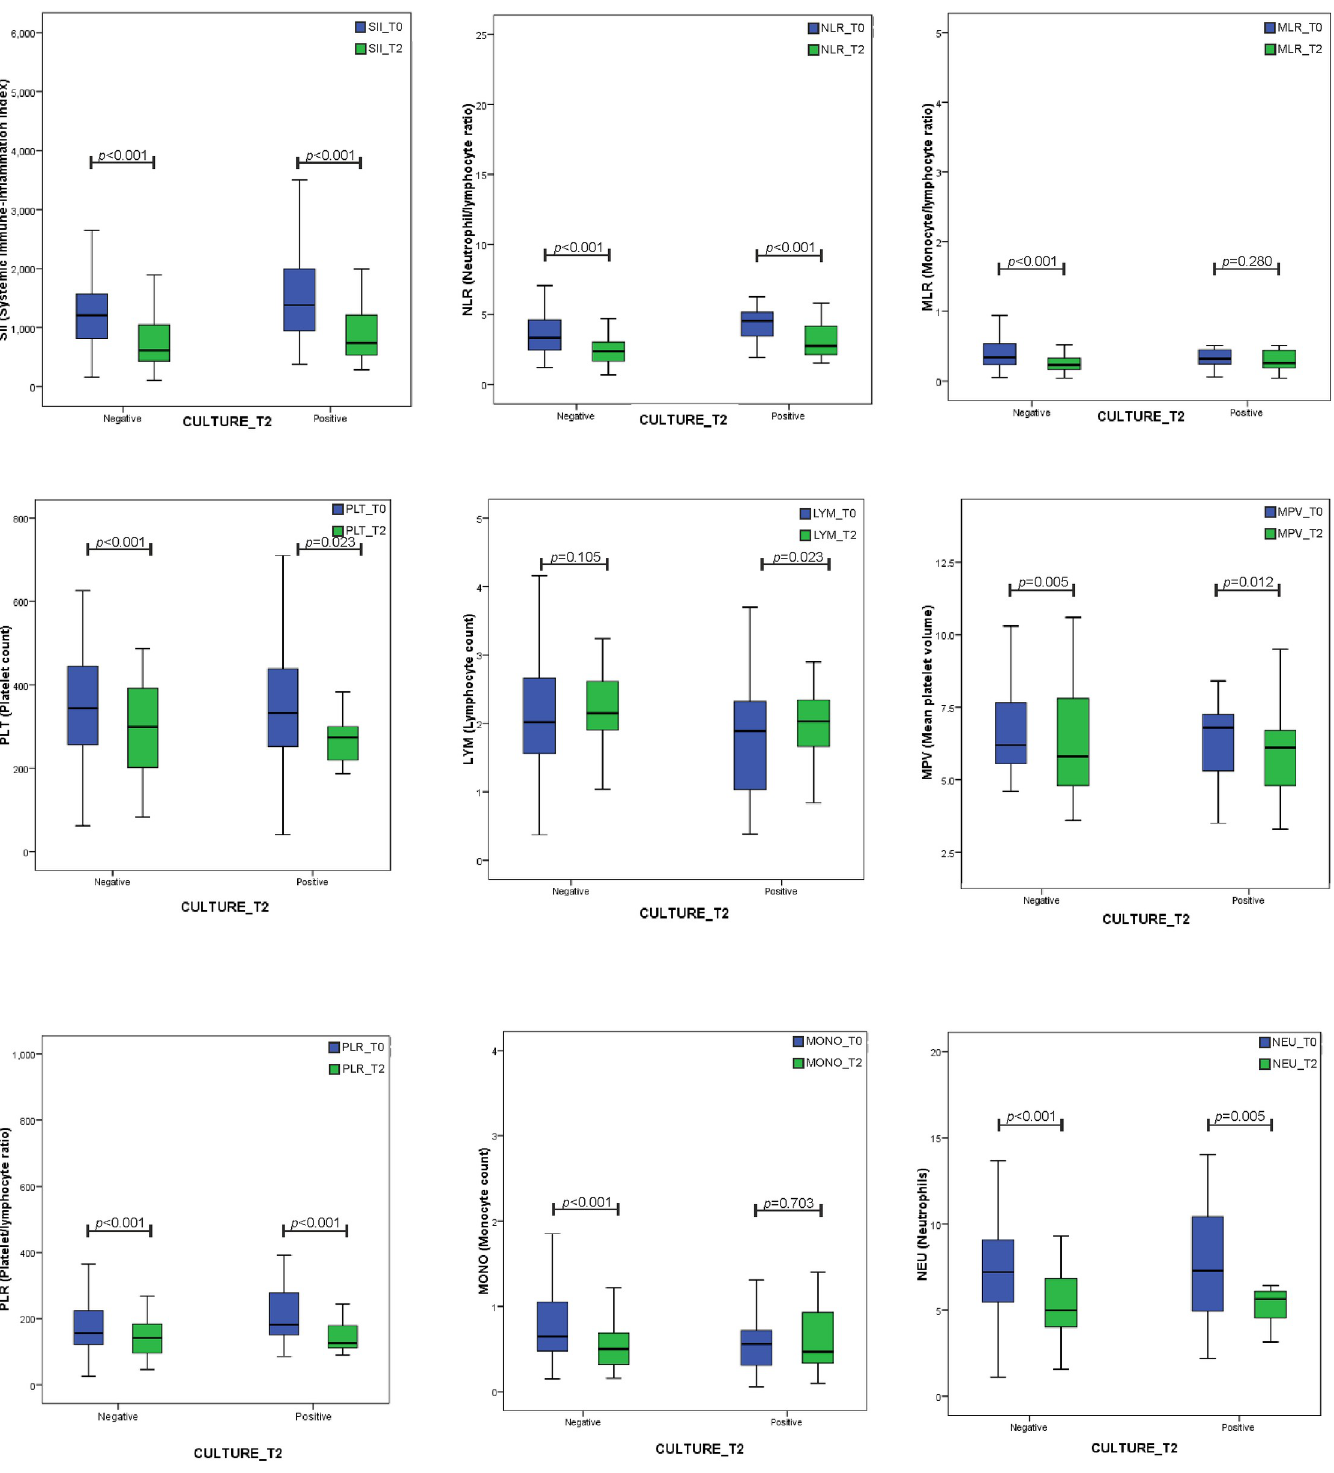
Fig 1. Comparative box-plots for some hematological parameters. Box-and-whisker plots representing median of SII, NLR, MLR, PLT, LYM, MPV, PLR, MONO and NEU levels. Blue box designates a boxplot of value at T0. Green box designates a boxplot of the value at T2. The horizontal line inside the box indicates the median value. Whiskers extend to the largest and smallest observed values within the box lengths. In each box plot, P (Negative) = T0 vs. T2 for patients turned negative culture at T2 (in left), n = 63 and P (Positive) = T0 vs. T2 for patients remained positive culture at T2 (in right), n = 27. Statistically significant deviations between groups (p < 0.05) are indicated by a horizontal line.